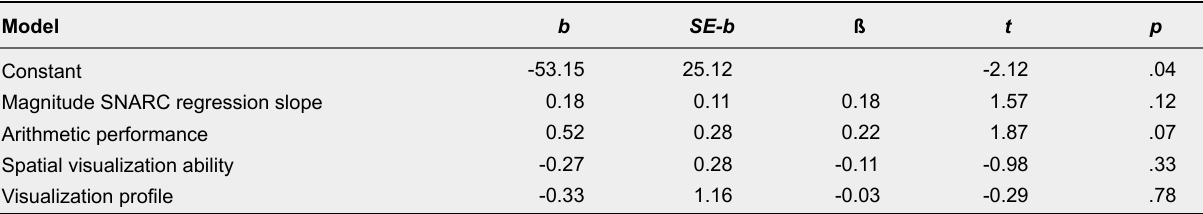
Multiple Linear Regression Analysis on the Parity SNARC Regression Slopes Model